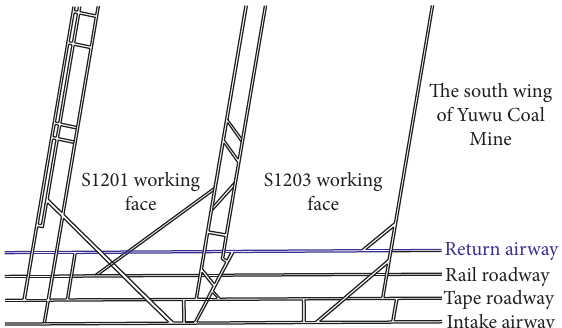
Figure 1: General situation of south wing return airway of Yuwu coal mine.